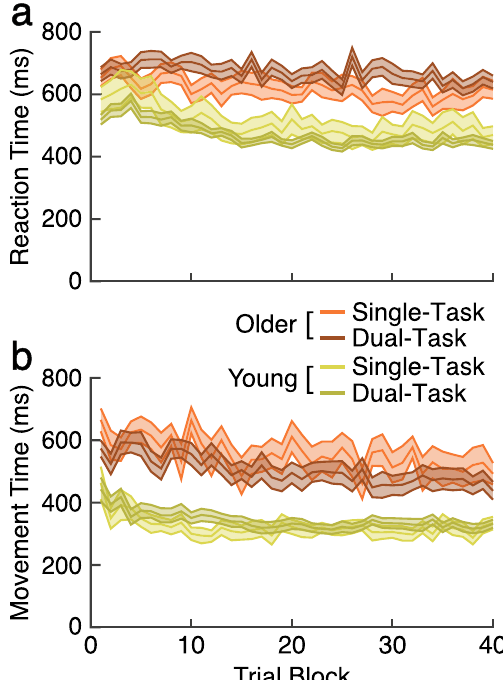
Figure 3. Reaction time (RT) and movement time (MT) in the learning phase. We compare performance in young (green) and older (orange) adults across the single task (lighter color) and dual-task groups (darker color). Ribbons indicate SE. ( a ) Reaction time. ( b ) Movement